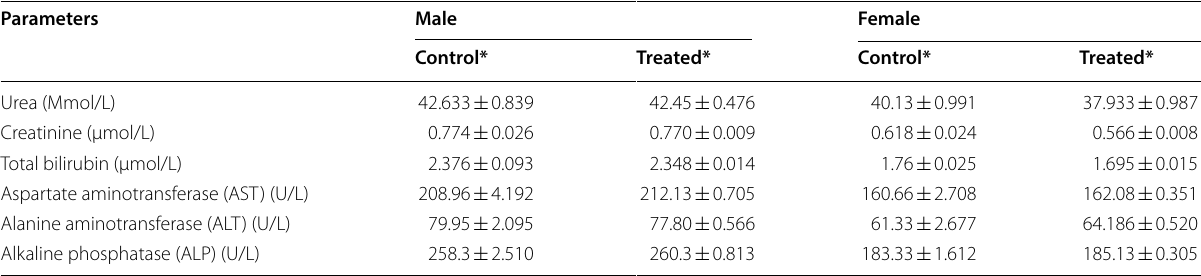
Table 6 Effect of Berberis aristata diterpenes on biochemical parameters in acute oral toxicity study